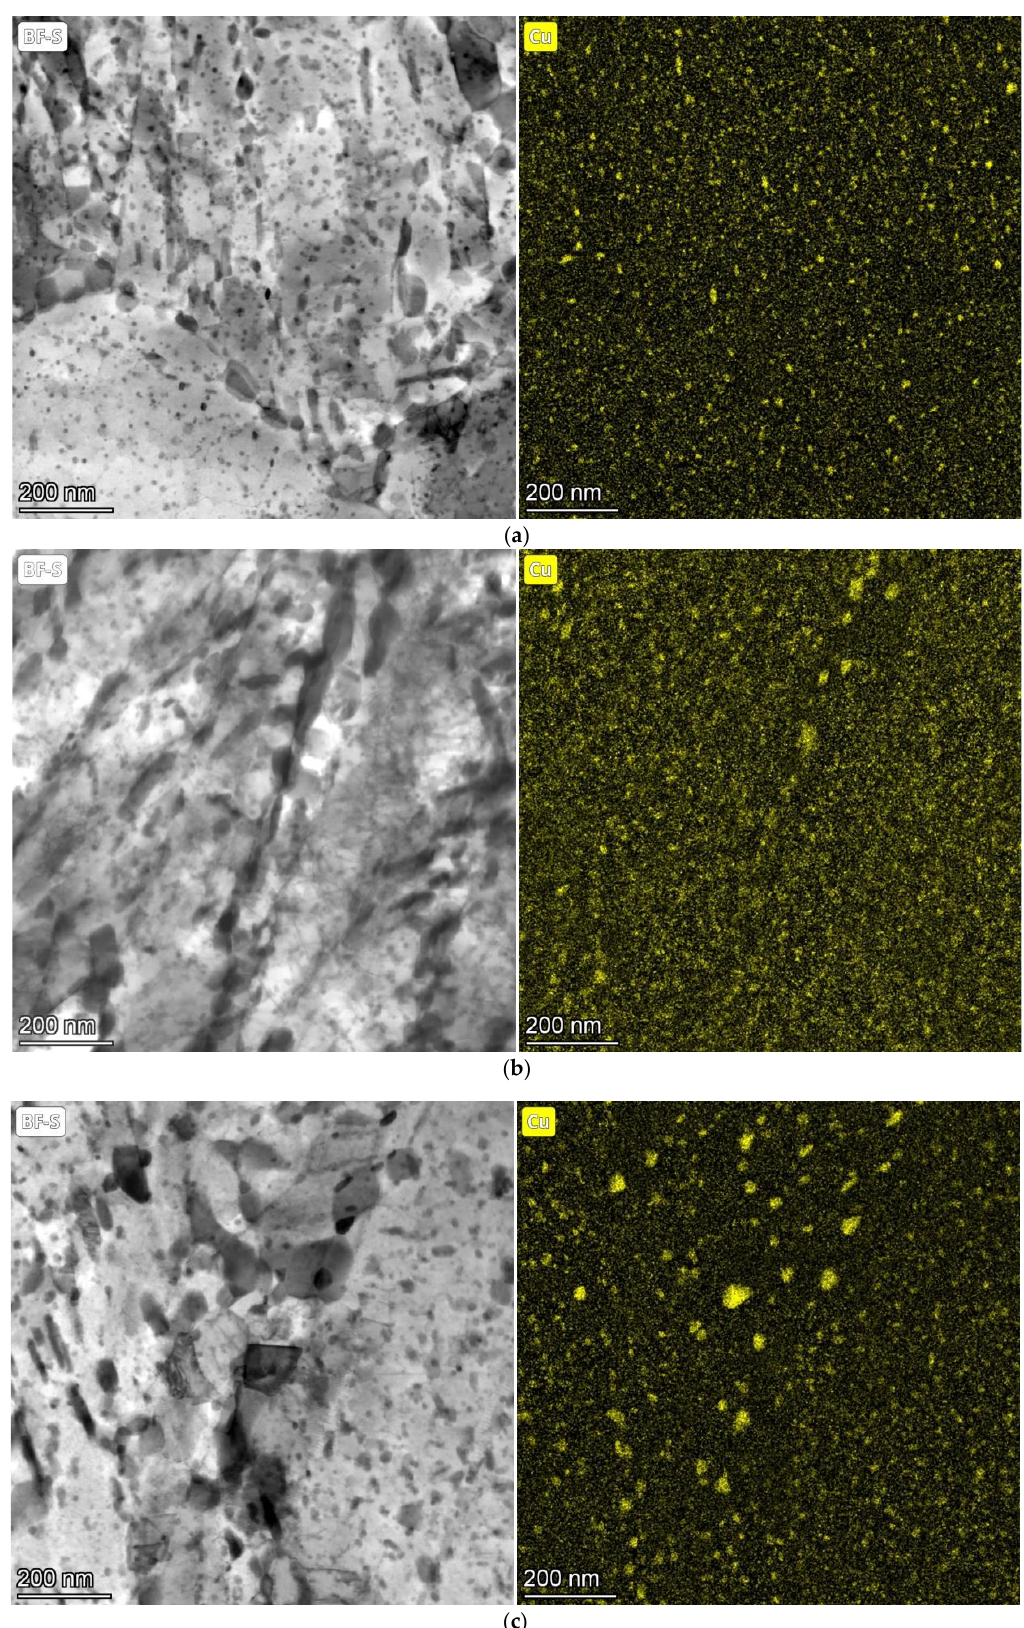
Figure 7. Evolution of Cu precipitates in 1.5 Cu steel during tempering at 500 °C for 12 h ( a ); 24 h ( b ); and 48 h ( c ). Table 3. The size evolution of Cu precipitates inside the martensitic needles after tempering at 500 °C for 12 h, 24 h and 48 h.